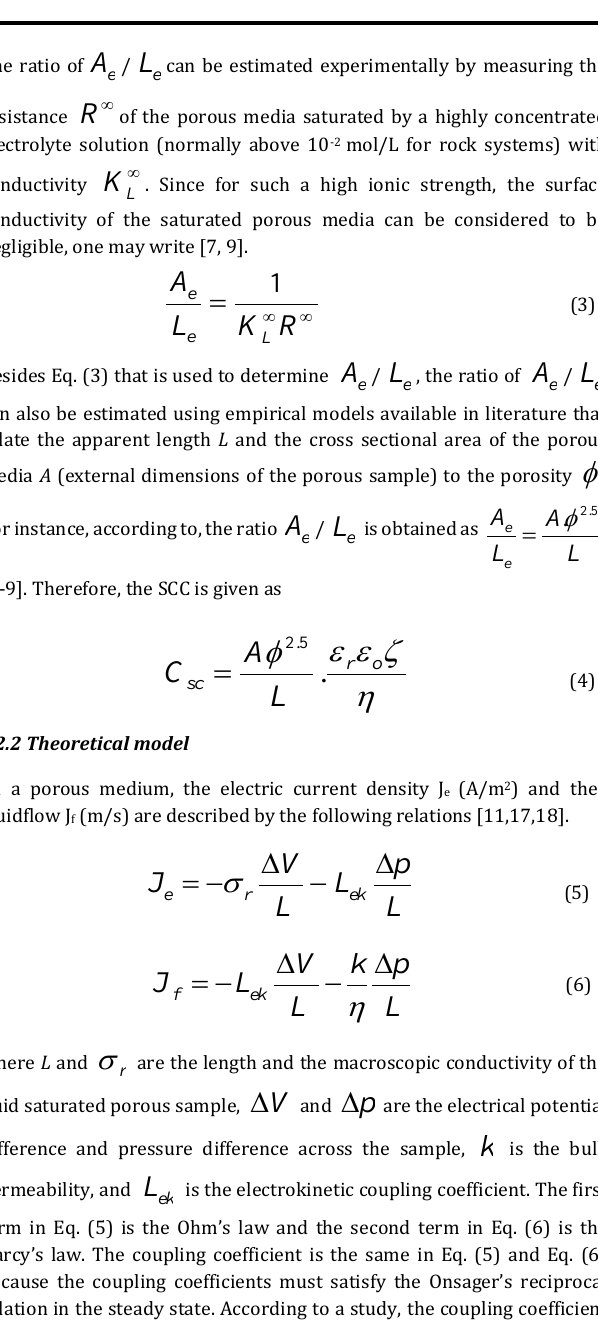
Figure 2: Developme